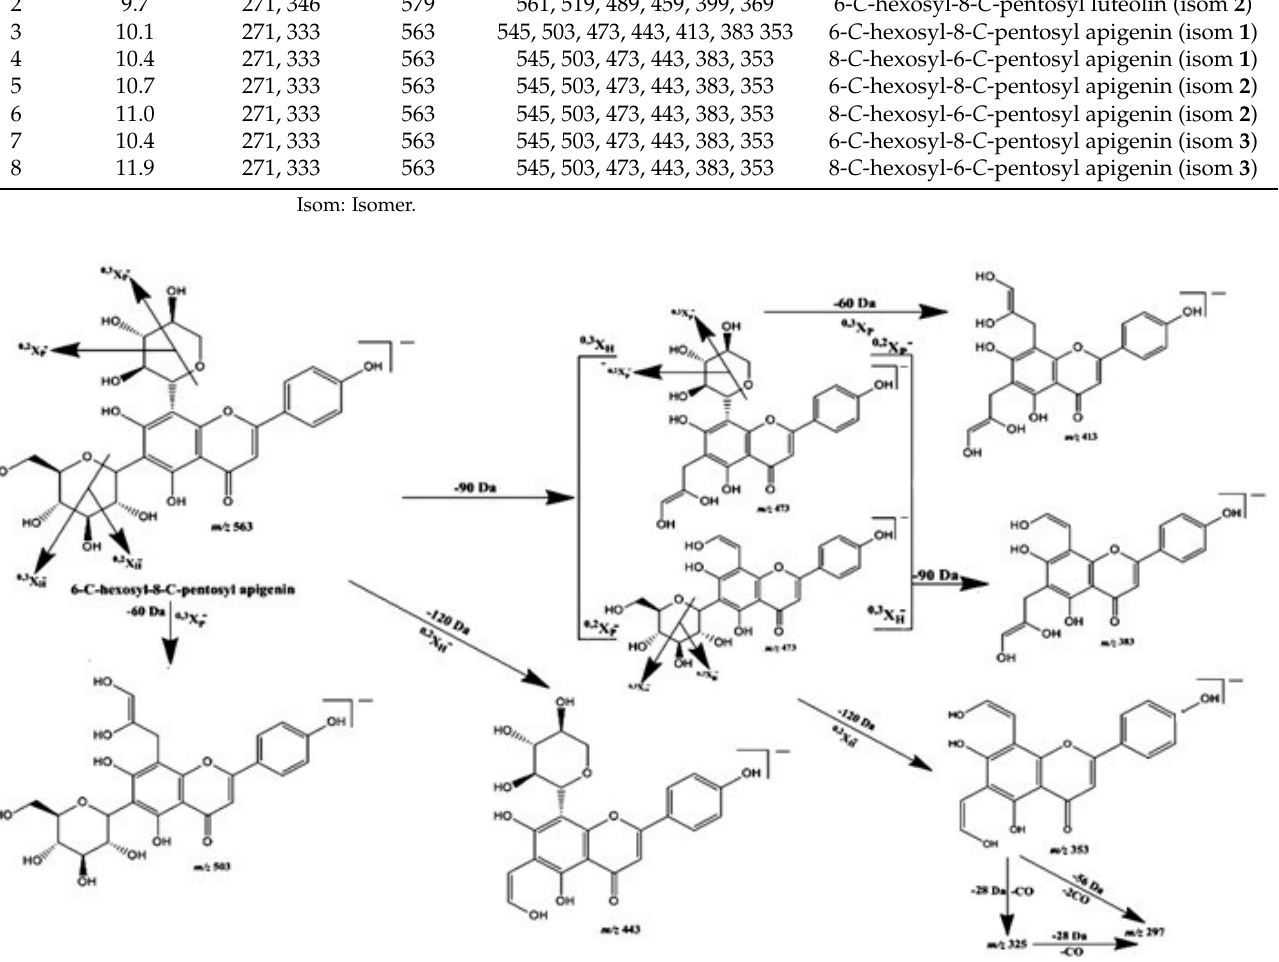
Figure 1. Proposed fragmentation pattern of 6- C -hexosyl-8- C -pentosyl apigenin in negative ion